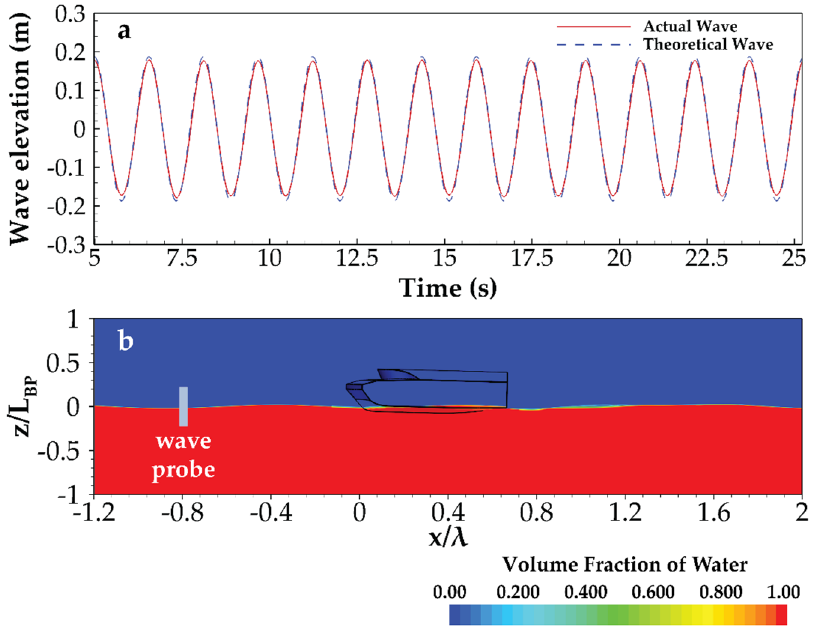
Figure 10. Wave height measurement at x = − 0.8 λ : ( a ) Comparison of the real wave with the theo- retical wave. ( b ) The Volume Fraction of Water, λ /L = 1.50.